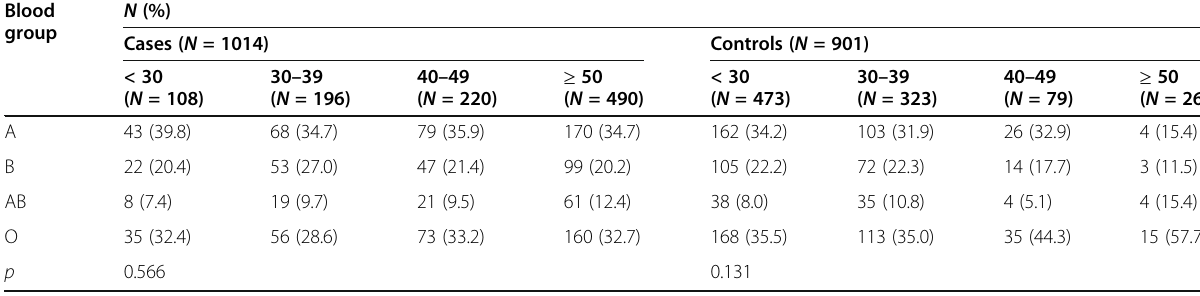
Table 3 ABO blood groups in COVID-19 cases and controls distributed according to age groups Blood